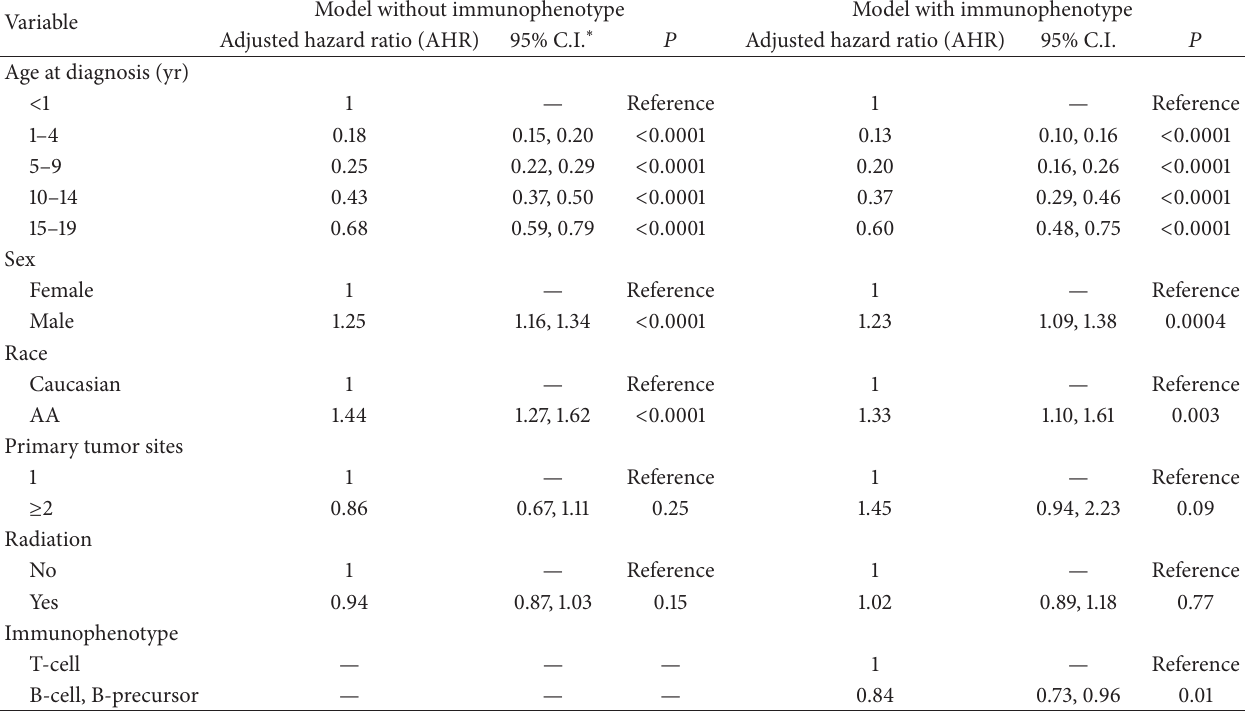
Table 3: Hazard risk of mortality associated with age at diagnosis in pediatric ALL patients (1973–2009 SEER dataset) in an adjusted multivariable Cox proportional hazard model, stratified by the year of diagnosis.